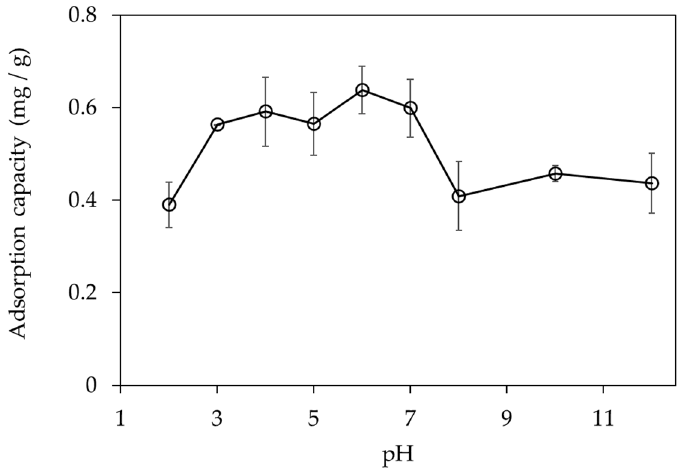
Figure 6. Effect of pH on removal of cisplatin by Si-DTC.